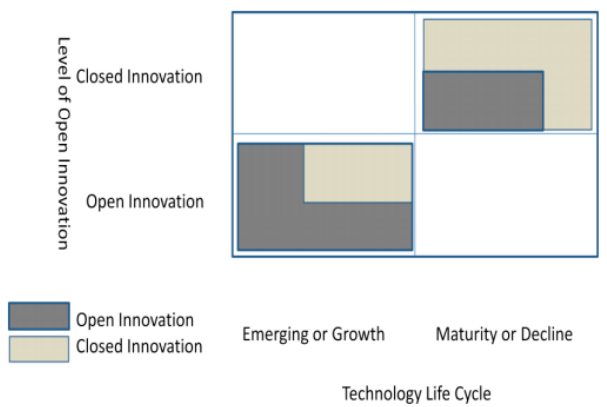
Figure 1. Relationship between Technology Life Cycle and Open Innovation.